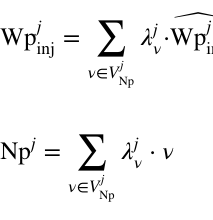
Table 13 Field properties used